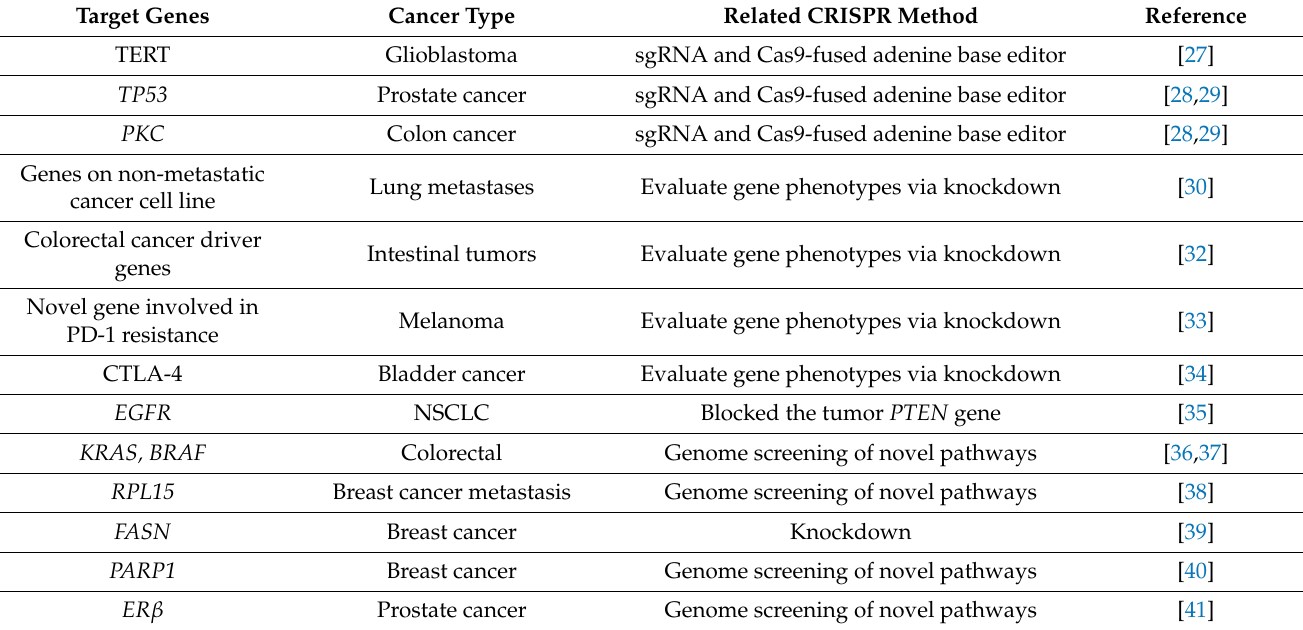
Table 1. CRISPR’s potential